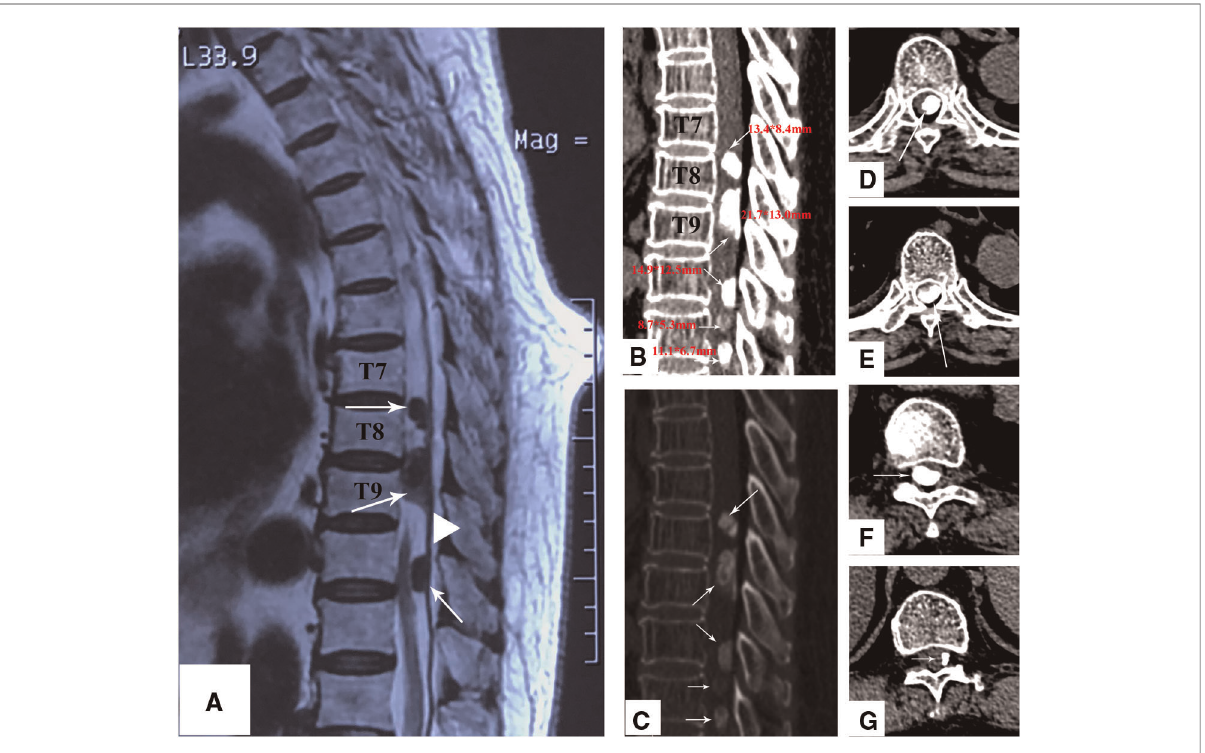
FIGURE 1 ( A ) Sagittal T2-weighted MRI shows three large lesions at the T7 – T11 level with low signal intensity. The lesions shown with a dural tail sign. ( B,C ) The sagittal CT scan shows that there are fi ve different sizes of high-density masses at the T7 – T8 ( D ), T8 – T9 ( E ), T10 – T11 ( F ), and T11 – T12 ( G ), levels, and all of them are located at the posterior of the spinal